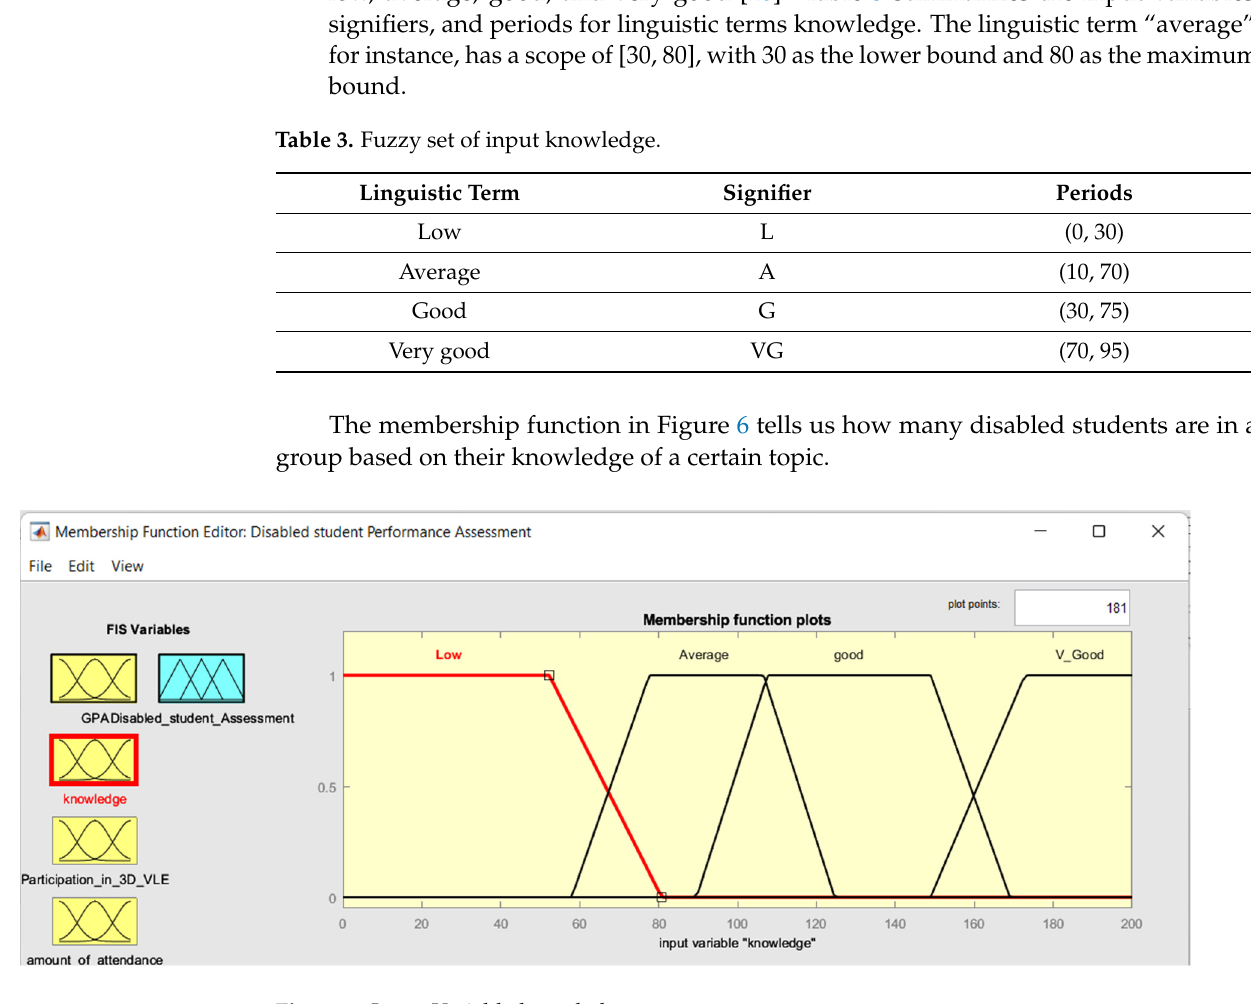
Table 4. Fuzzy set of input Participation in 3D